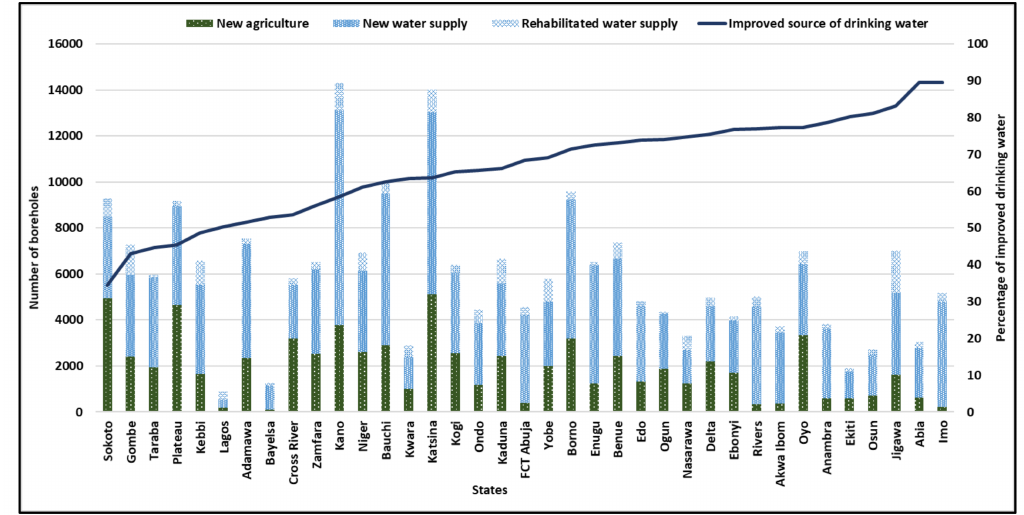
Figure 10. New and rehabilitated boreholes to meet SDG 6 in 2030: Improved drinking water sources and agriculture needs in Nigerian states